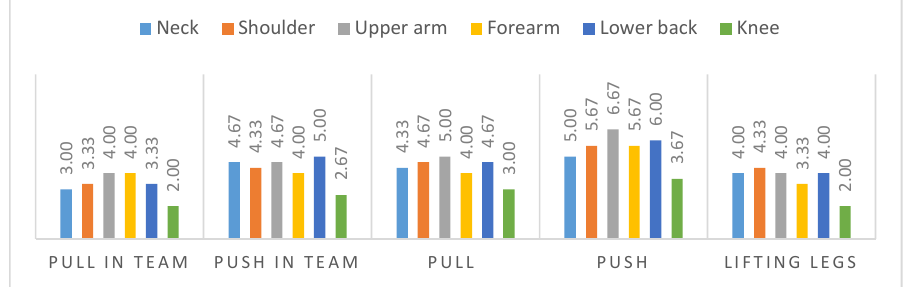
Figure 10. Results of subjective perception for application scenarios. “Pull in Team” and “Push in Team” refer to the cases where four caregivers are involved, while for “Pull” and “Push” they are only two.